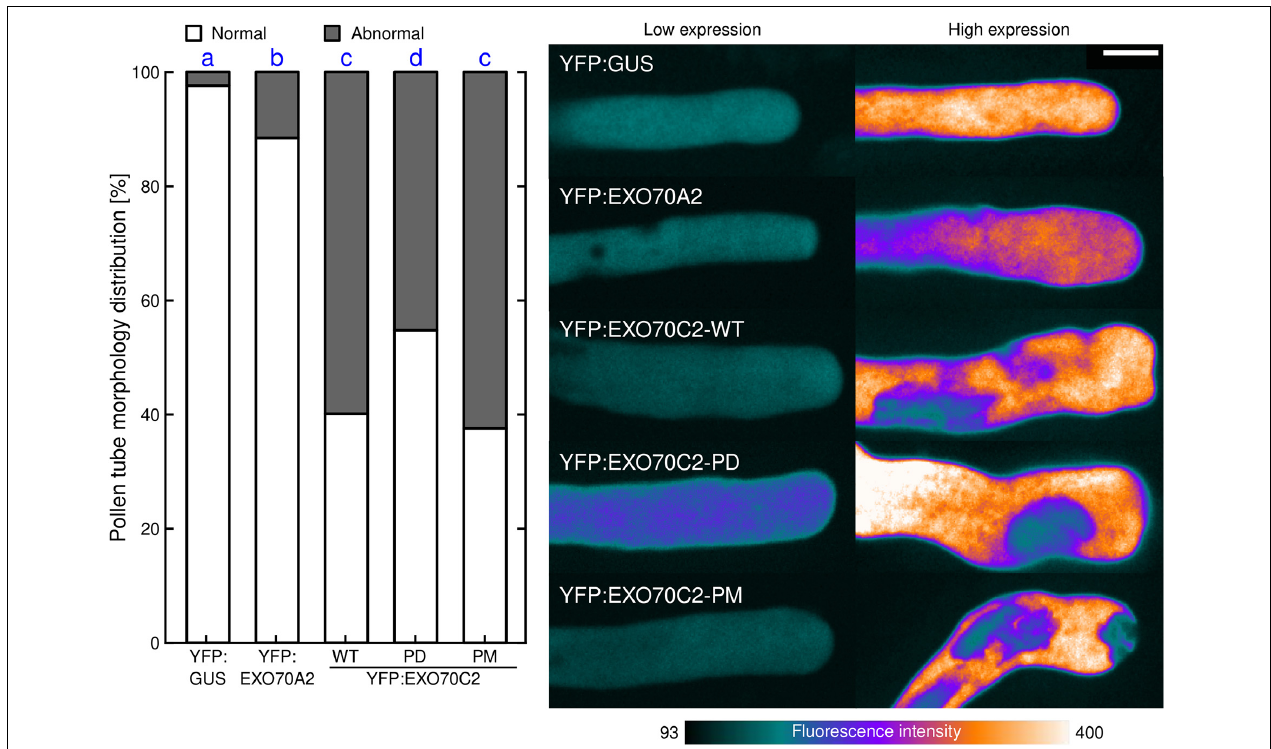
FIGURE 6 | Changes in cell morphology induced by EXO70C2 are controlled by its phosphorylation status. Tobacco pollen tubes were transiently transformed with YFP:AtEXO70C2 wild type (WT), phospho-dead (PD), and phospho-mimetic (PM) variants and imaged 8 h after transformation by spinning disk confocal microscopy. Cells expressing YFP:GUS and Arabidopsis YFP:EXO70A2 were used for comparison. Left, frequencies of pollen tubes exhibiting normal or abnormal morphology (abberant cell shape, membrane invaginations). At least 61 cells per variant were imaged in three independent experiments. Different letters indicate significant differences between samples at P < 0.05. Right, typical images displayed using a color intensity code with the same pixel range set for all images (i.e., reflecting differences in protein expression levels). Bar 10 µ m.